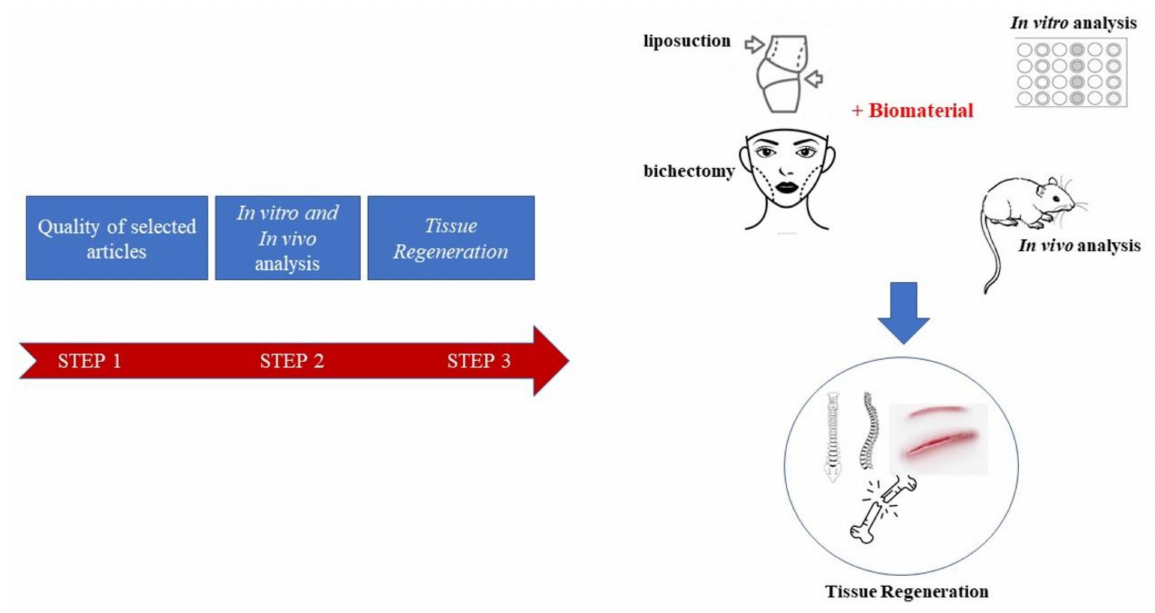
Figure 1. Schematic flow diagram of the review’s